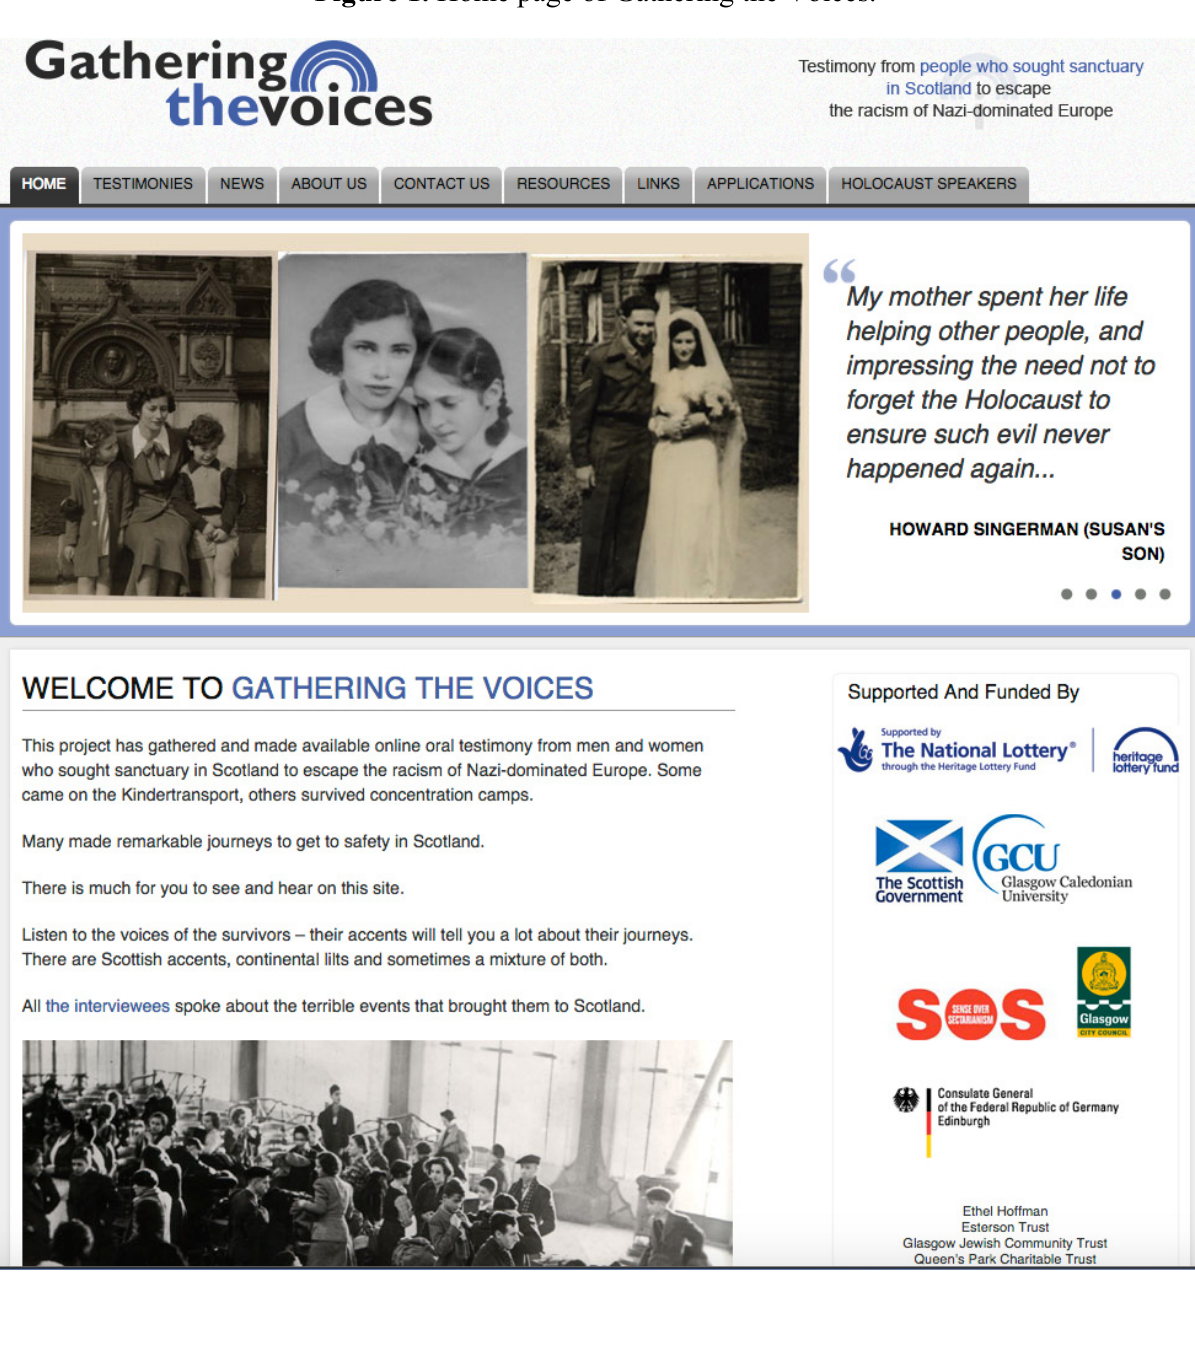
Figure 1. Home page of Gathering the